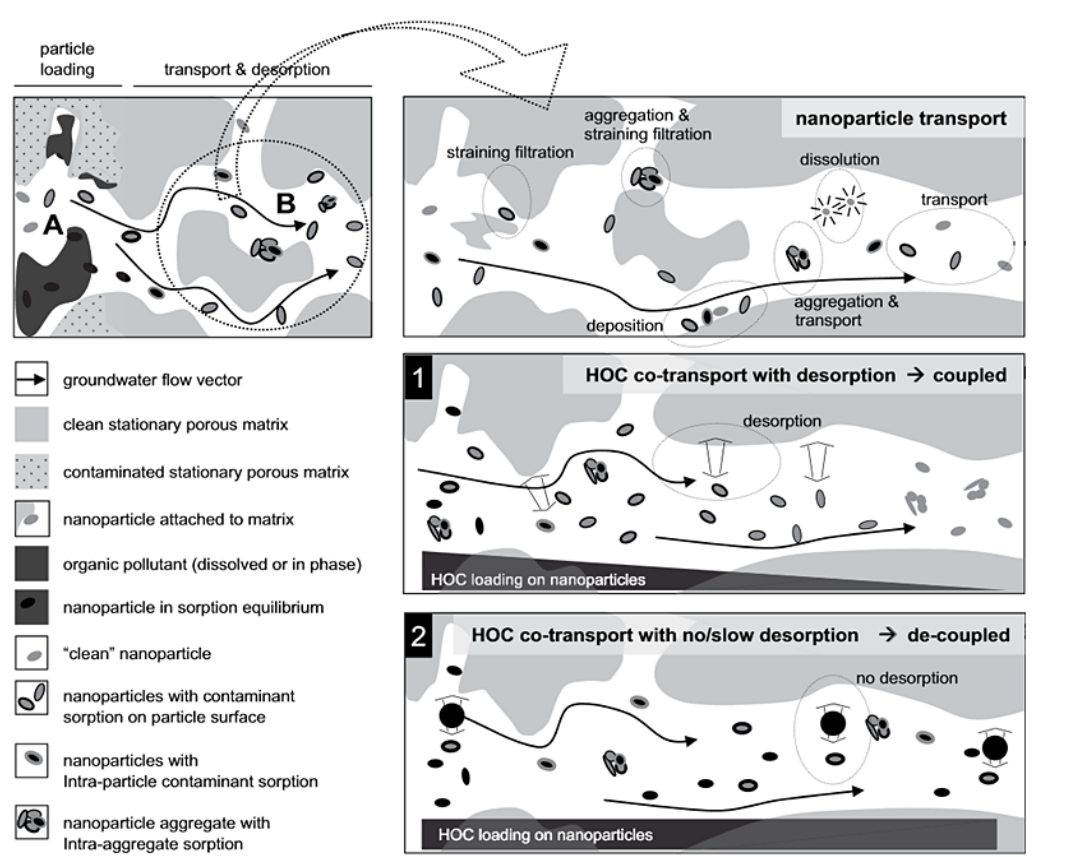
Figure 1. “Worst case scenario” processes by which CNMs may facilitate the transport of HOCs. Top-left panel: (A) HOC equilibrates with CNM and is (B) transported. The top-right panel shows the processes by which CNMs may be transported. The centre-right panel (1) shows the transport and rapid desorption of HOCs from CNMs. Equilibrium is achieved between the liquid phase, CNM and matrix. The bottom-right panel (2) shows slow desorption kinetics, with no desorption from the CNM (Hofmann and von der Kammer, 2009). Re-printed with permission from Elsevier ©